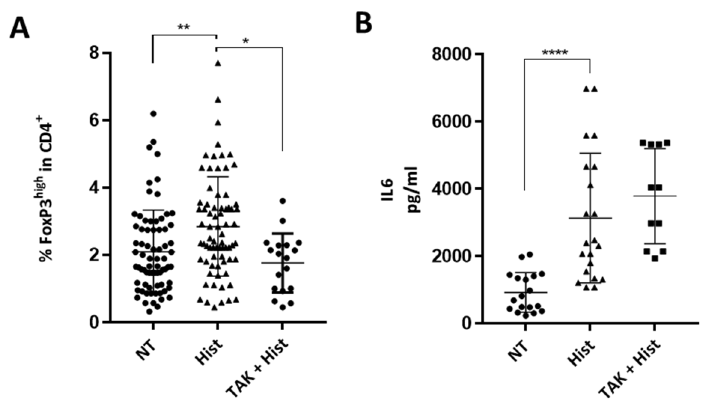
Figure 2. Endothelial activation mediated by histones induce Treg proliferation. ( A ) Comparison of Treg expansion after three days of coculture, with HMECs, pre-stimulated or not with histones, and with or without TAK 242 pre-incubation. Results are presented as the percentage of CD4 + CD25 + CD127 low FoxP3 high among CD4 + cells. Gating was performed using Fluorescence Minus One (FMO) control. Histone pre-treatment increased Treg expansion (Kruskal–Wallis test, ** p = 0.002), and this was strongly reduced by TLR4 inhibition (Kruskal-Wallis test, * p = 0.011, (n = 18–73)). ( B ) IL-6 was measured in co-culture supernatants. Histone pre-treatment increased IL-6 secretion in co-culture, and this was not reversed by TLR4 inhibition (Kruskal–Wallis test, **** p < 0.0001 (n = 12–23)).